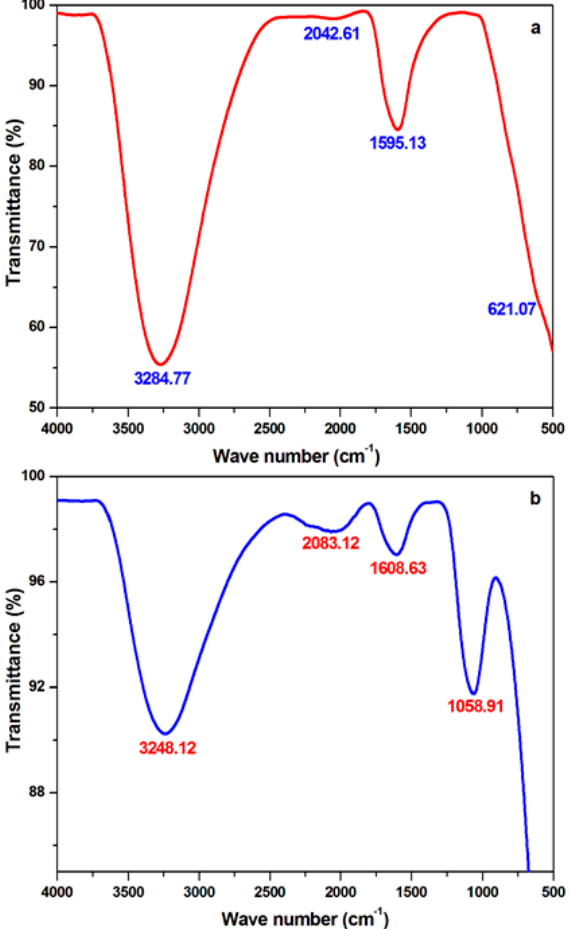
Figure 8. FT-IR spectrum of ( a ) T. aralioides corrosion inhibitor and ( b ) scrapped specimen. The strong peak was seen at 3284.77 cm − 1 corresponding to the -OH stretching vibration. The band for -C=C-, -C=O and -C-H stretching was observed at 1595.13 cm − 1 , 2042.61 cm − 1 and 621.07 cm − 1 , respectively. The FT-IR spectrum of the scrapped specimen displayed a stretching frequency at 3248.12 cm − 1 , 2083.12 cm − 1 , 1608.63 cm − 1 and 1058.91 cm − 1 , which are the performance of -OH, -C=O, -C=C- and -C-O-C- stretching vibrations, respectively. The shifts in stretching frequencies indicated that the inhibitor physically or chemically interacted on the surface of the metal. As per FT-IR data, the heteroatom of phytochemical constituents present in the inhibitor acted as a Lewis base and formed a protective layer on the metal’s surface preventing corrosion [55–60].